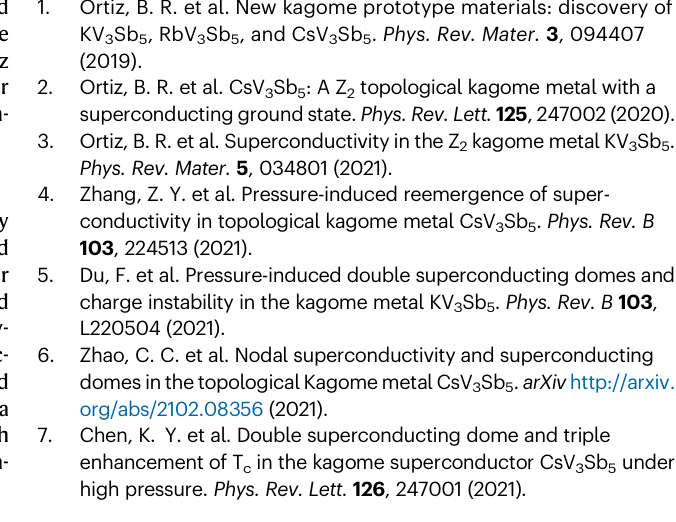
Fig. 4 | Scaling relation, band structure and the density of states in gated CsV3Sb5. a The scaling relation of AHC against the longitudinal conductivity in devices#4and#7(withthicknessaround50nm).Nearthehighconductivityregion (above 5×10 5 Ω − 1 cm − 1 ), the giant AHE is dominated by the skew scattering (#4 at 4.5V and #7 at 3.8V). At − 4.6V (#4, electron band), the AHE is dominated by the intrinsic Berry curvature. b Band structures of the paramagnetic phase with dif- ferentdopinglevelsinCsV 3 Sb 5 .Ne refersthe chargenumberineachprimitive cell.